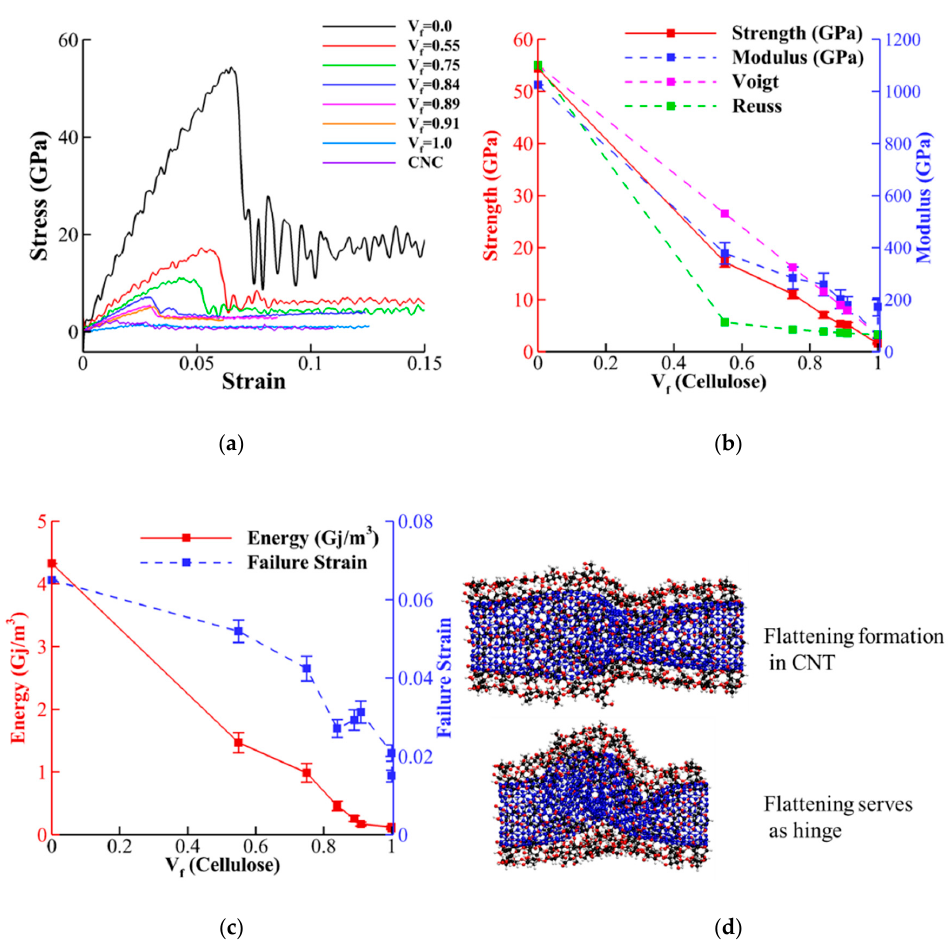
Figure 7. Compressive properties of CNT-wrapped cellulose at different cellulose content. ( a ) Stress-strain curves. ( b ) Variation of strength and Young’s modulus for different cellulose content is shown. ( c ) Variation of toughness and failure strain for different cellulose content is shown. ( d ) Buckling for CNT-wrapped single walled cellulose ( V f = 55%) shows flattening and hinge formation in CNT similar to those observed in pristine CNT [65].